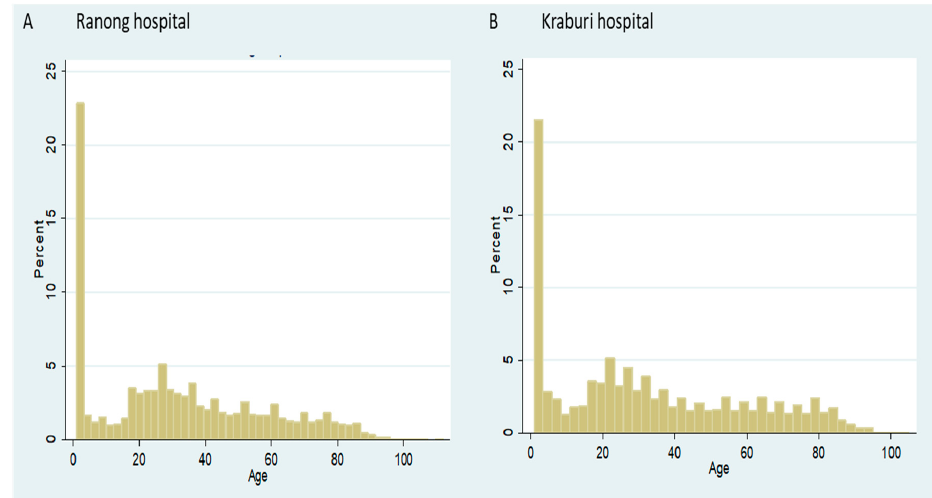
Figure 2. Percentage of inpatient (IP) utilisation volume in Ranong Hospital ( A ) and Kraburi Hospital ( B ) by age.